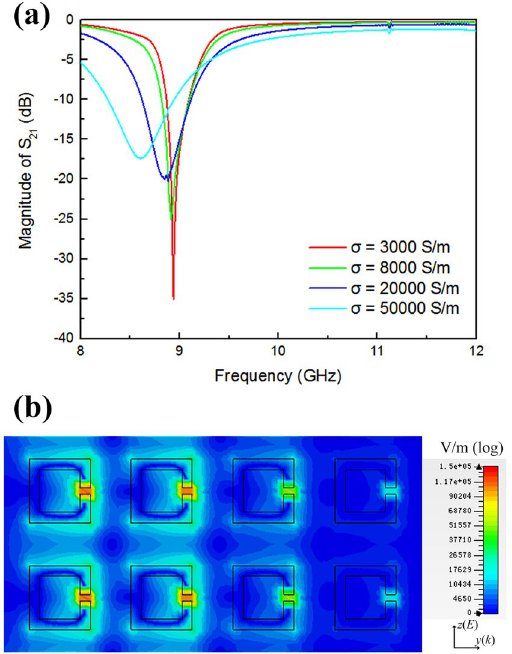
Figure 4. Numerical simulation results. ( a ) Transmission spectra when altering the conductivity of VO 2 ( σ ). ( b ) Electric field distribution at σ = 3000